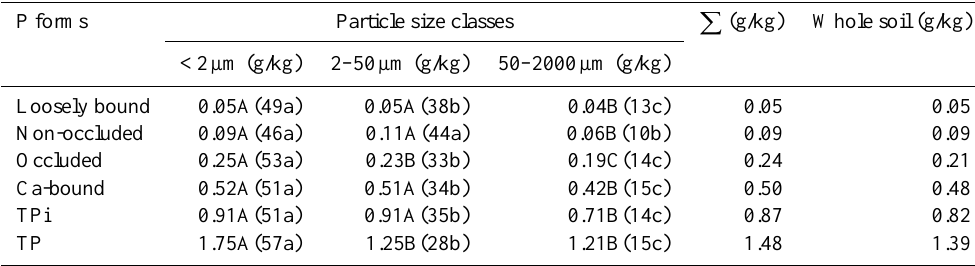
Table 3. Phosphorus forms in particle-size fractions of the riparian